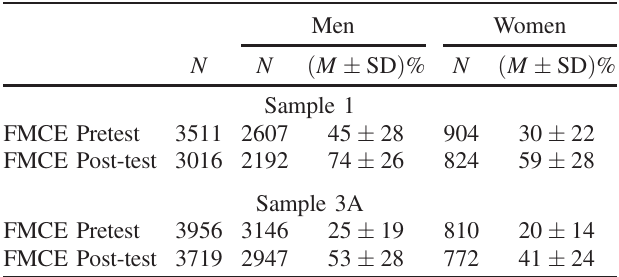
TABLE II. FMCE pretest and post-test averages for samples 1 and 3A. Averages are reported as